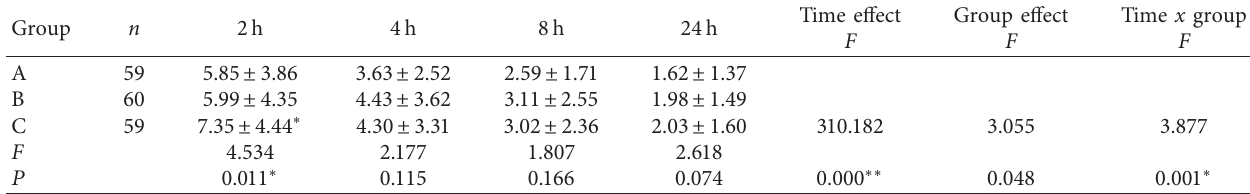
Table 2: Comparison of the total symptom scores after SMILE between the 3 groups at different postsurgery time points.